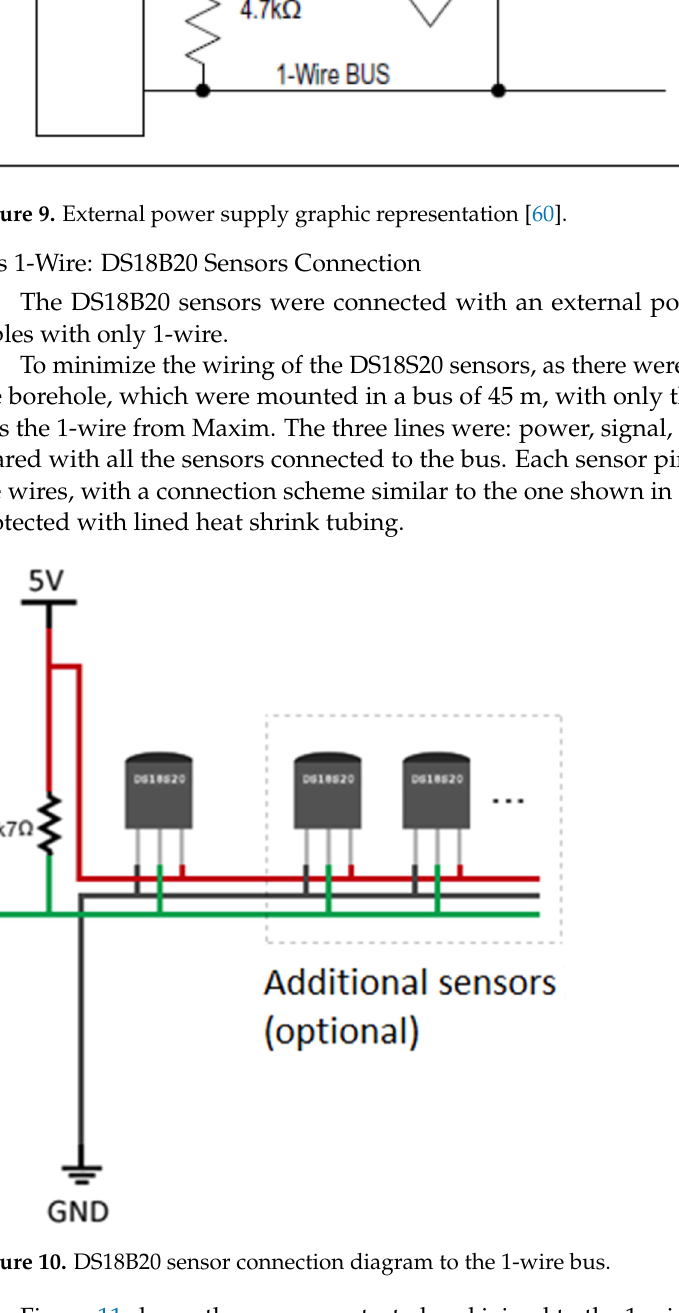
Figure 11. Sensor located on the 1-wire cable. The wire-1 and a set of sensors were introduced in a PVC monolayer hose, which can tolerate high pressures and demonstrate high flexibility at low temperatures. This assem- bly protects the sensors against pressure and water effects. This hose had an external di- ameter ( ED ) of 10 mm and an inner diameter ( ID ) of 8 mm (Figure 12). Figure 12. DS18B20 sensor on the 1-wire bus inside the protection hose. The hose was filled with vegetable oil, due to its biodegradable characteristics, and then it was sealed at the part that will be located at the bottom of the borehole. Similar 1-wire devices were manufactured for each borehole, although with different sensor separations. In the Q-Thermie-uniovi-1 borehole, the sensors were located every 5 m, while in the Q-Thermie-Uniovi-2, the sensors were separated 2 m. The distance value